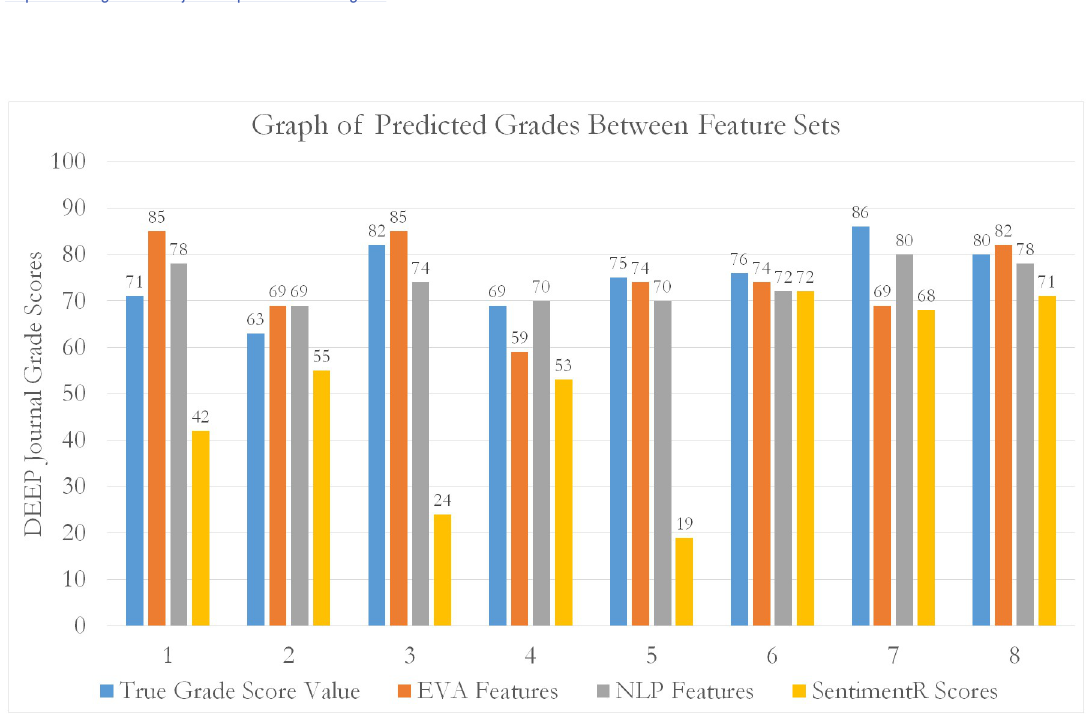
Fig 12. A bar chart showing the distribution of predictions of student grade scores from EVA, NLP and SentimentR feature sets against expected (real) grade scores awarded by course assessors. The predictions were made through MLP.